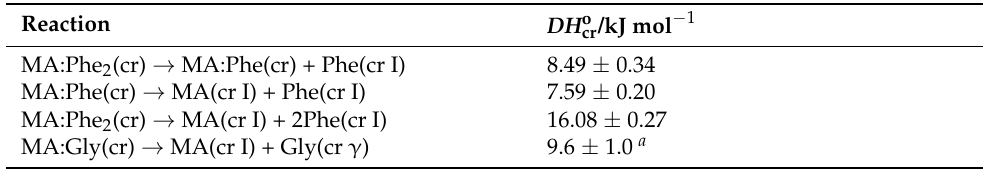
Table 4. Dissociation enthalpies at 298.15 K for MA:Phe 2 , MA:Phe, and MA:Gly.